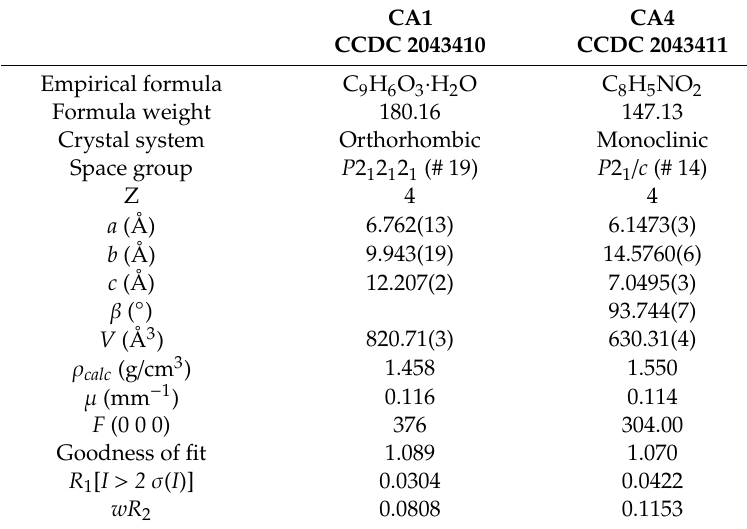
Table 1. Crystallographic data of CA1 and CA4 .